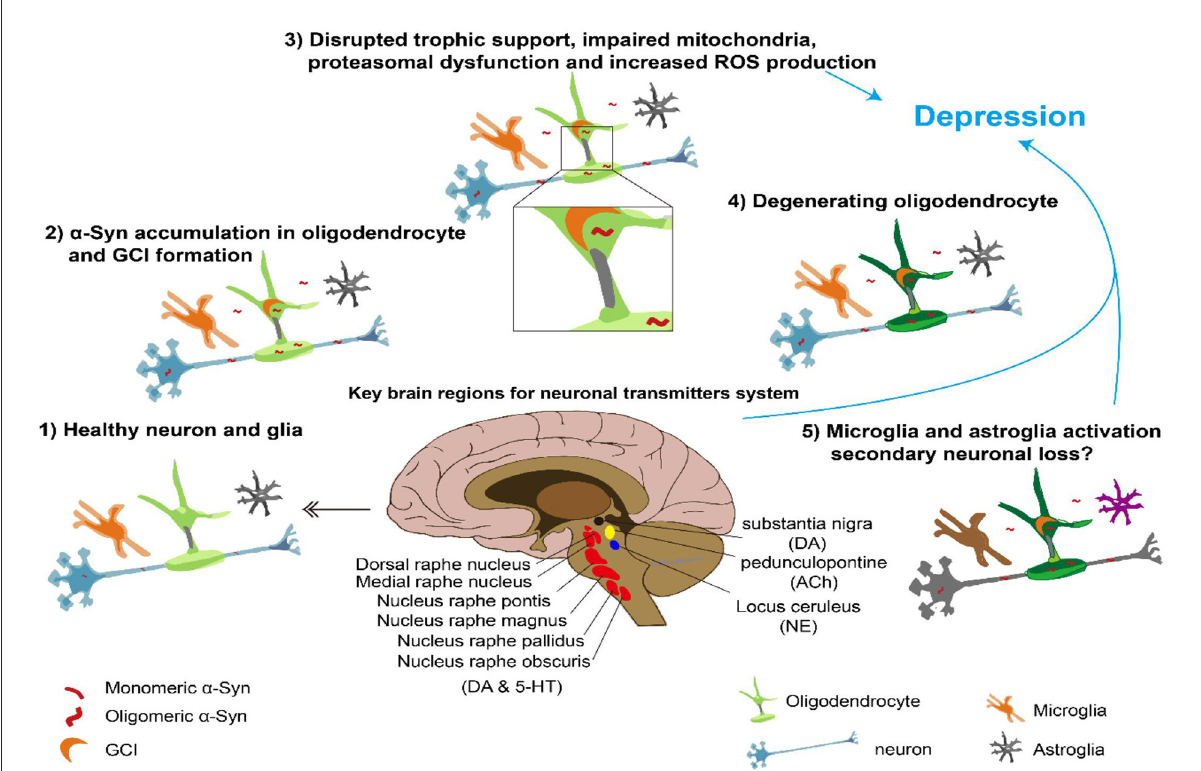
FIGURE1 Overview of pathological a-synuclein accumulation leading to MSA and depression Center, brain regions important for neural transmitter involved in depression. Surround, possible process underlying MSA and depression. DA, dopamine; ACh, acetyl choline; NE, norepinephrine; 5- HT,